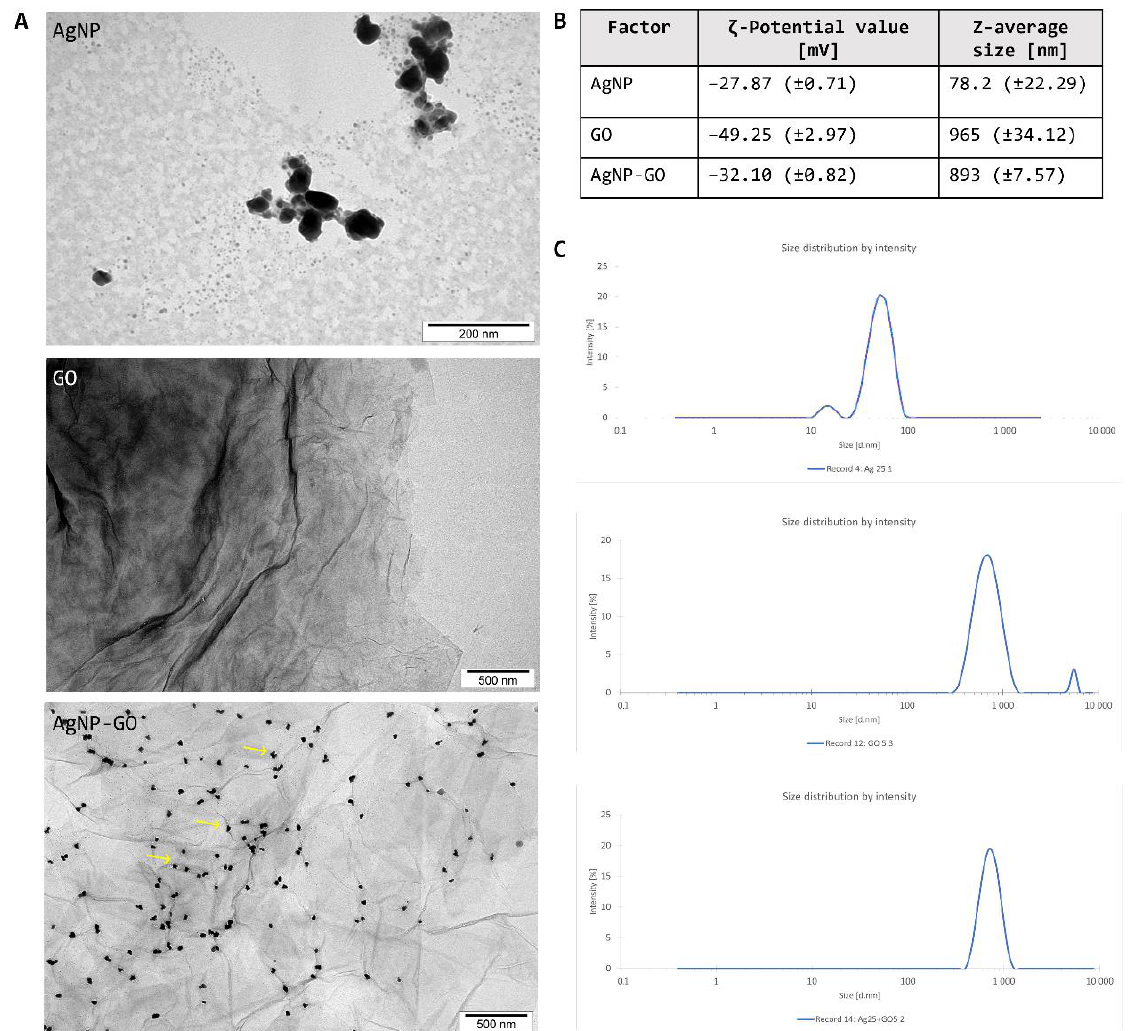
Figure 1. The characterization of the experimental factors. ( A ) The transmission electron microscopy (TEM) visualization of the AgNP, GO, and AgNP-GO complex. Examples of AgNP adhesion places are marked by yellow arrows. ( B ) Zeta potentials and Z-average size by dynamic light scattering analysis of the evaluated nanomaterials. ( C ) Size distributions of the analyzed hydrocolloids in water.